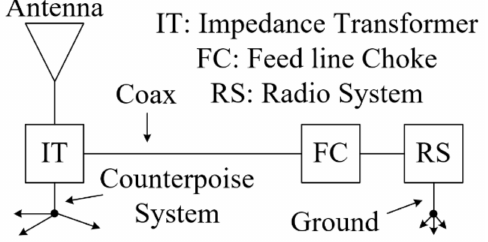
Figure 1. The diagram of typical end-fed antenna